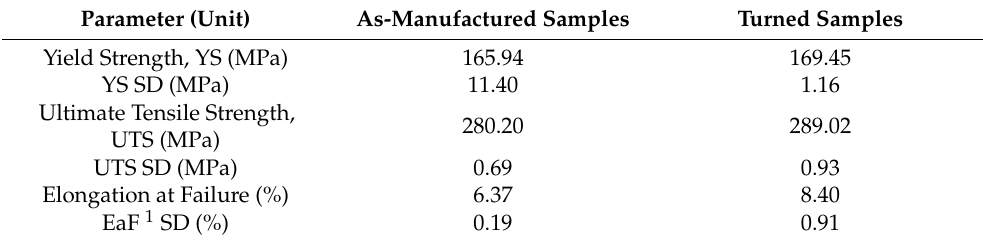
Table 3. Comparison between properties of as-manufactured and turned samples in terms of yield strength, ultimate tensile strength and elongation at failure as measured at room temperature on samples with polar angle 0 ◦ . Note that a sample stress–strain curve for a turned sample is also included in Figure 4a. Parameter (Unit) As-Manufactured Samples Turned Samples Yield Strength, YS (MPa) 165.94 169.45 YS SD (MPa) 11.40 1.16 Ultimate Tensile Strength, 280.20